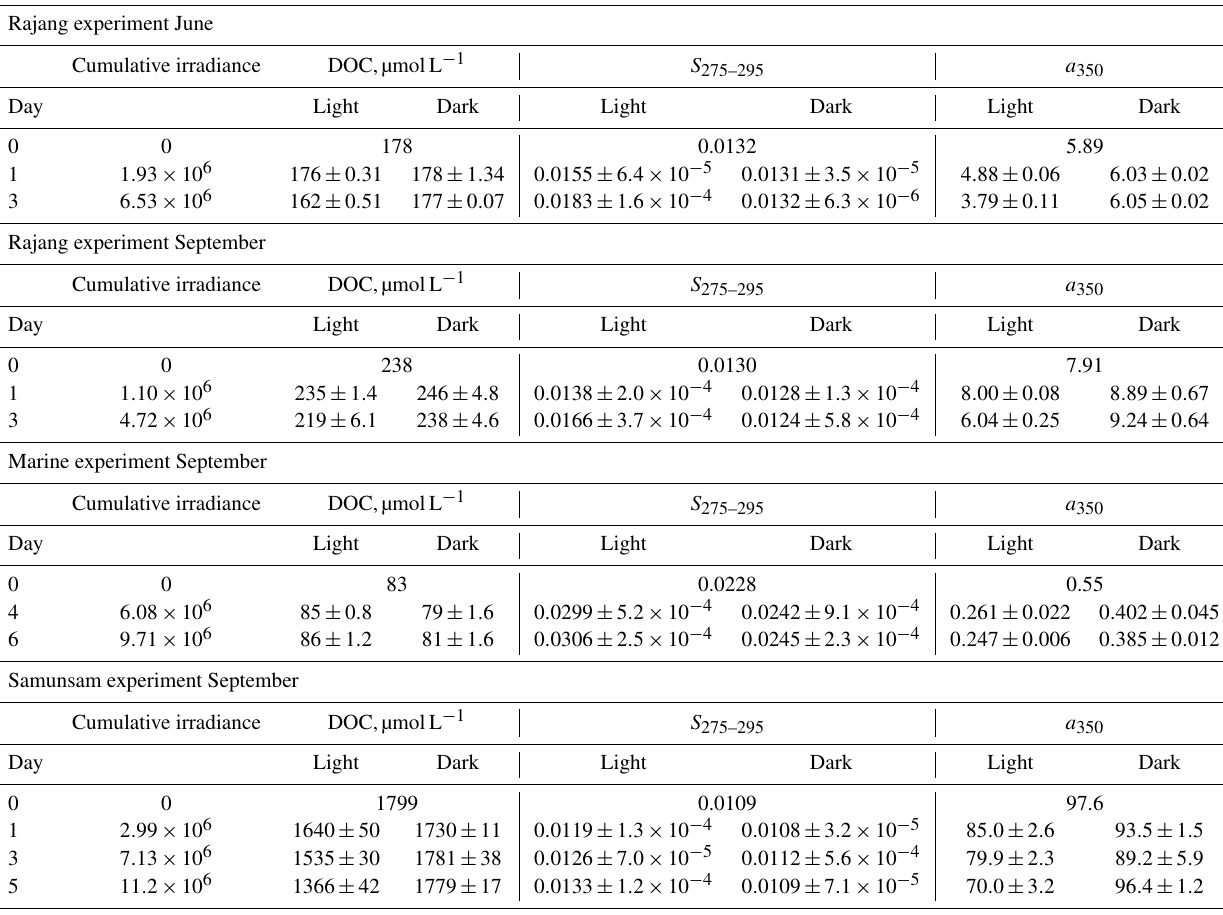
Table 1. Summary of results from photodegradation experiments for DOC, S 275–295 , and CDOM concentration ( a 350 ). All values are mean ± SD for each treatment. Day 0 data are the values measured at the corresponding station from which water for each experiment was taken. All irradiance data are in Joules m − 2 , integrated from 318 to